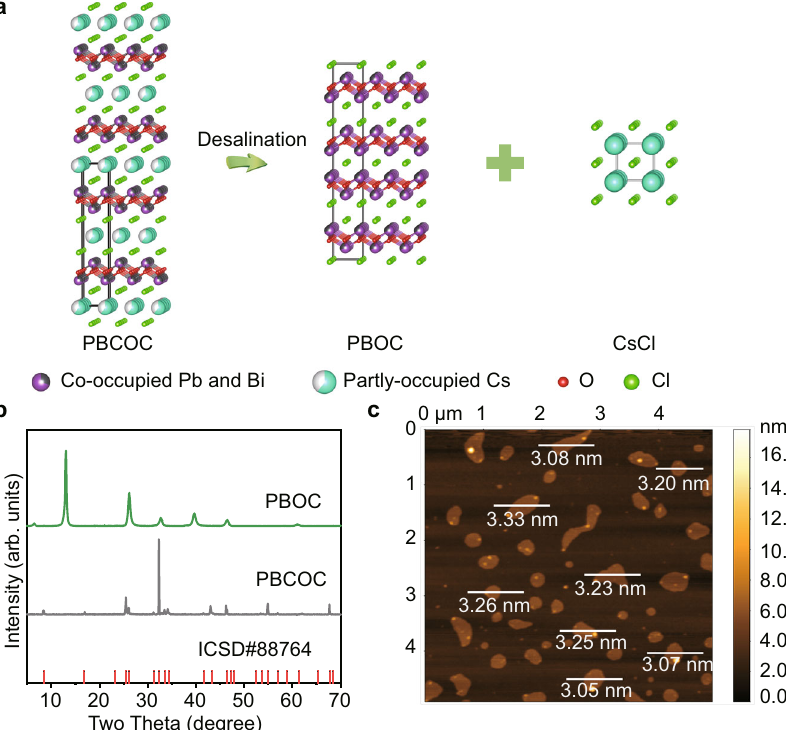
Fig. 1 Synthesis and characterization of ultrathin PBOC layers. a Schematic illustration of ultrathin PBOC layers synthesis from PBCOC via desalination strategy. b PXRD of PBCOC and PBOC. c AFM image of the as-synthesized ultrathin PBOC layers.